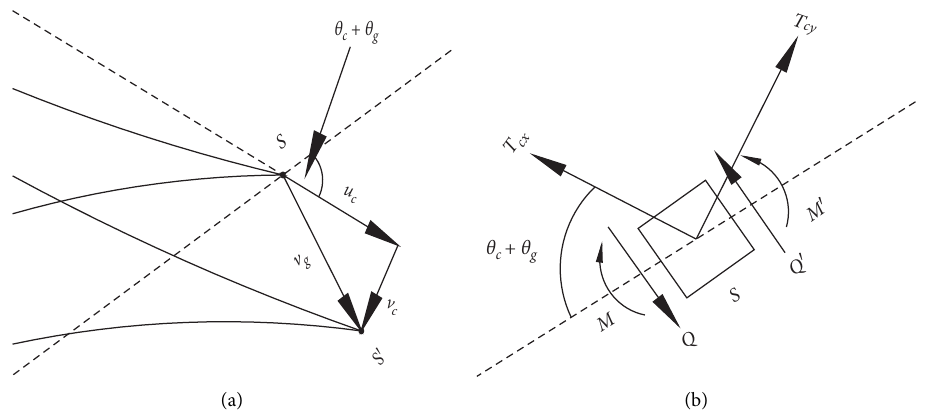
Figure 4: Schematic of the (a) geometric and (b) mechanical boundary conditions at the